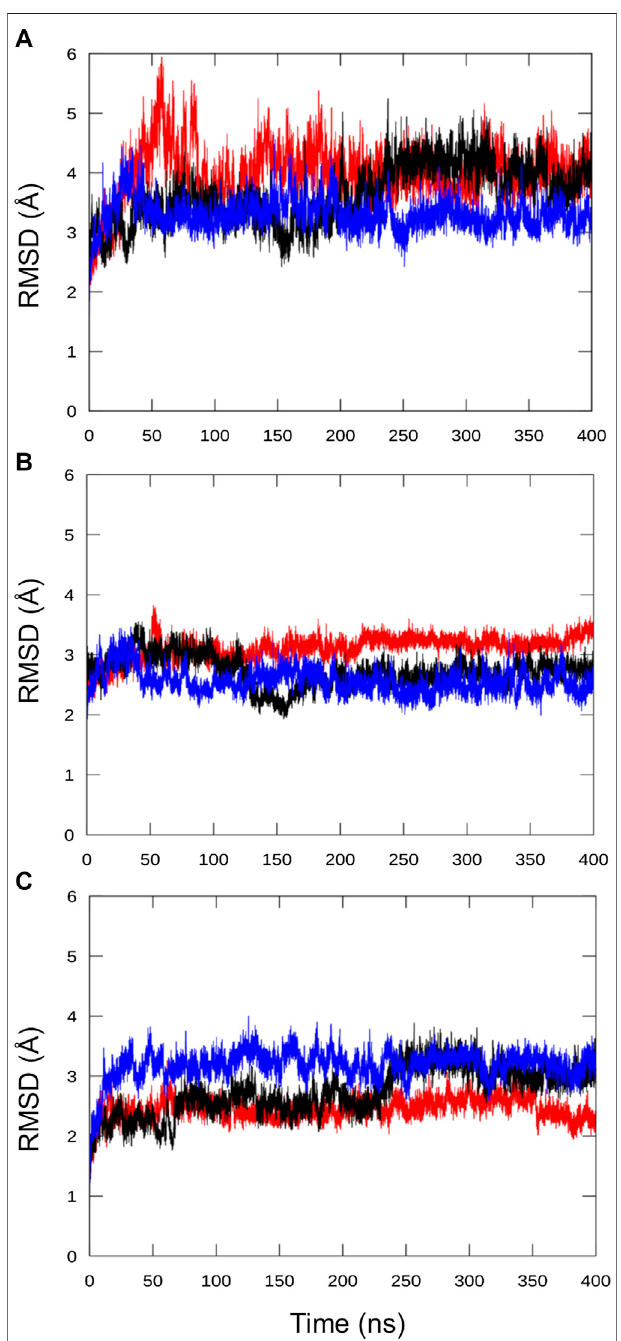
FIGURE 5 | Analysis of the chimera protein stability over the MD simulation time. RMSD was calculated on protein backbone atoms (C, C α , N, O,H)forthethreeindependentrunswithrespecttothere fi nedchimeramodel as a function of the simulation time. (A) all residues, (B) HD residues alone (5 – 159) and (C) SYNTH residues alone (178 –